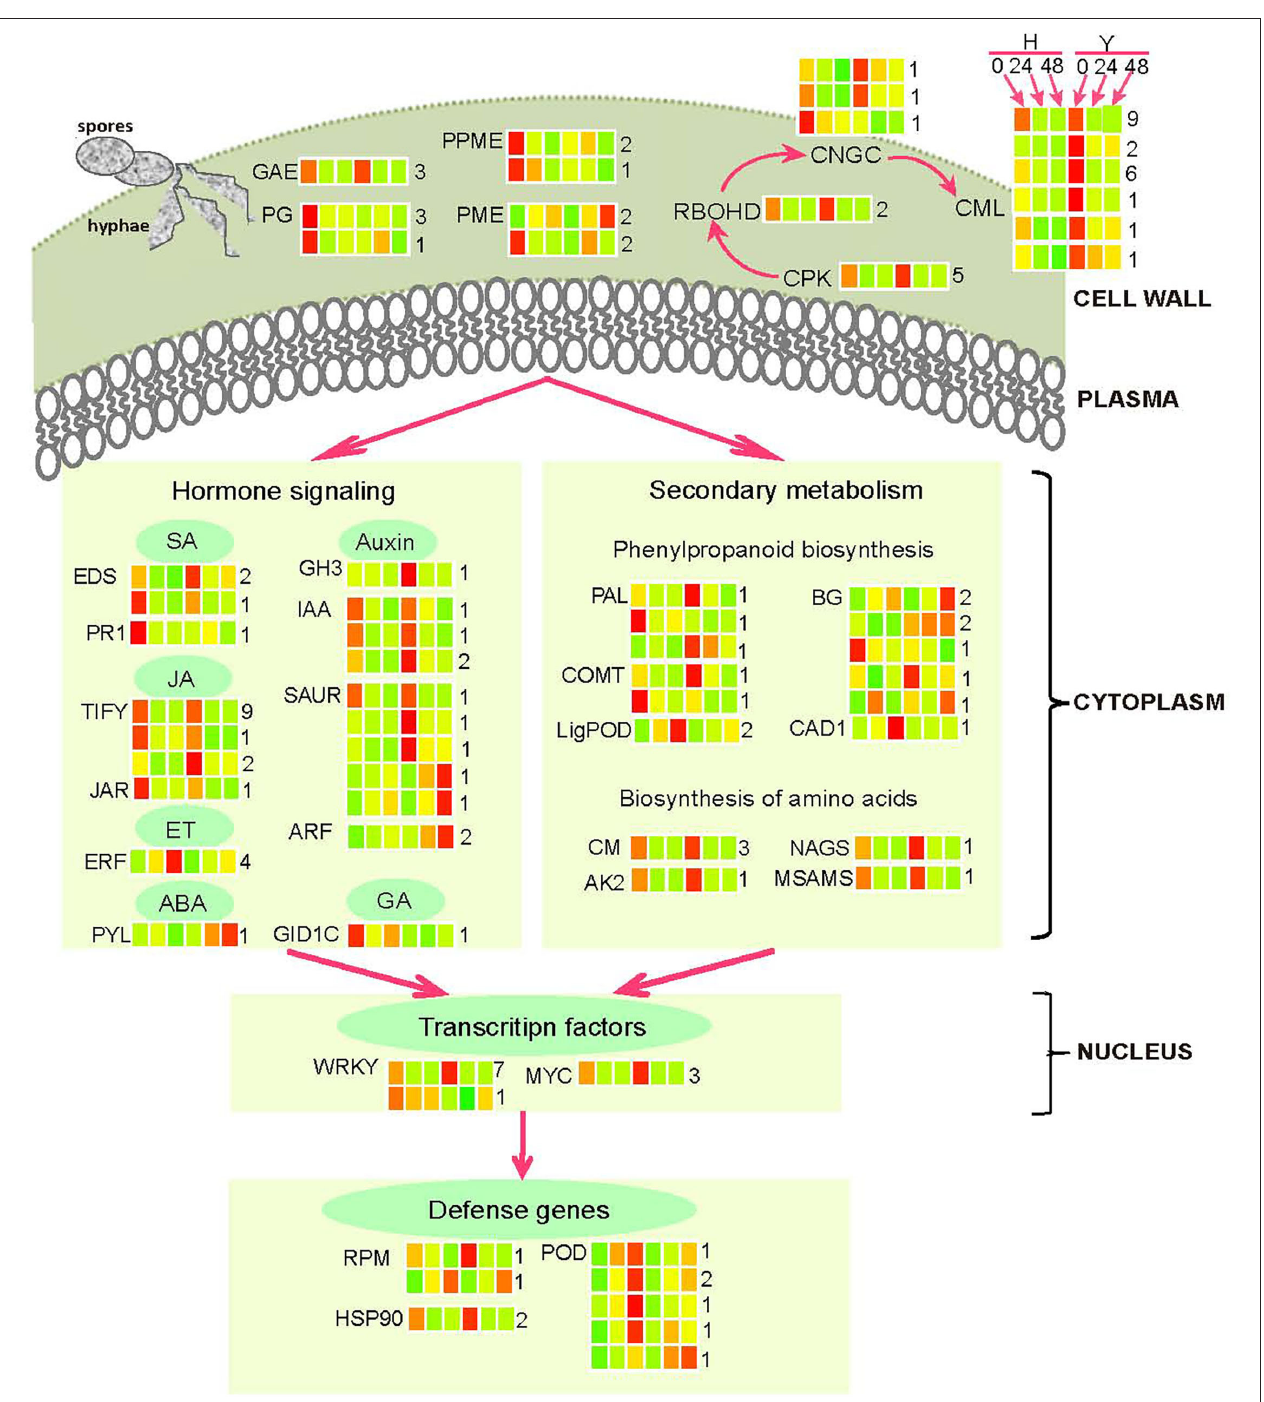
FIGURE 7 | General model summarizing B. cinerea resistance mechanisms in strawberry flowers. The red coloring represents up-regulation, green coloring represents down-regulation, and yellow indicates no significant change in heatmaps (infected leaves at 0, 24, and 48 hpi of the resistant cultivar Y and the susceptible cultivar H). The full name and gene accession numbers of differentially regulated genes are listed in Supplementary Table 2 . The numbers behind the heat maps represent the numbers of genes in the indicated